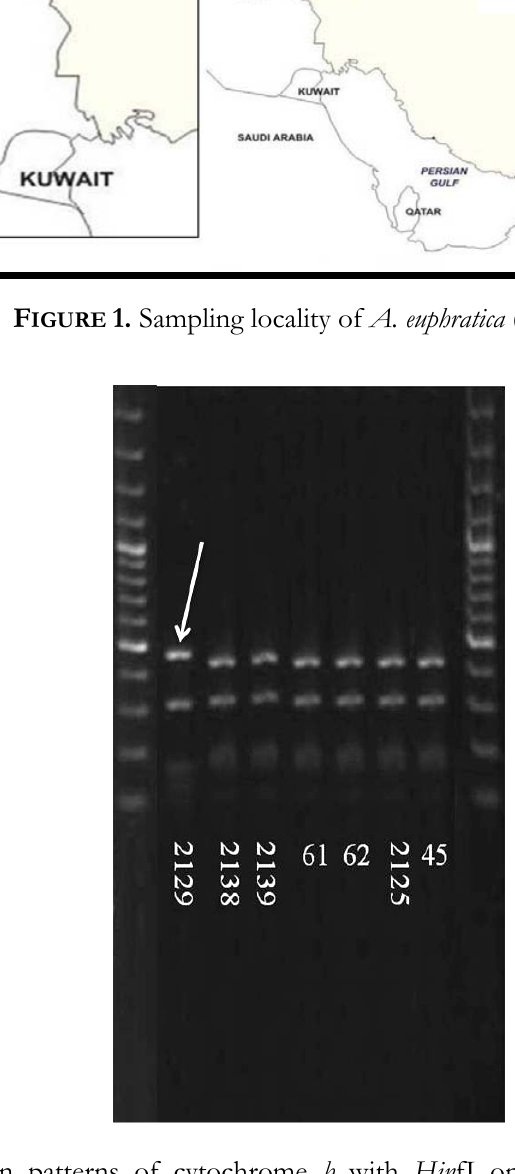
F IGURE 2. Restriction patterns of cytochrome b with Hin fI on 1% agarose gel [2129: Ilam (indicated with arrow); 2139, 2138, 2125: Ardebil; 61, 62: Zanjan; 45: